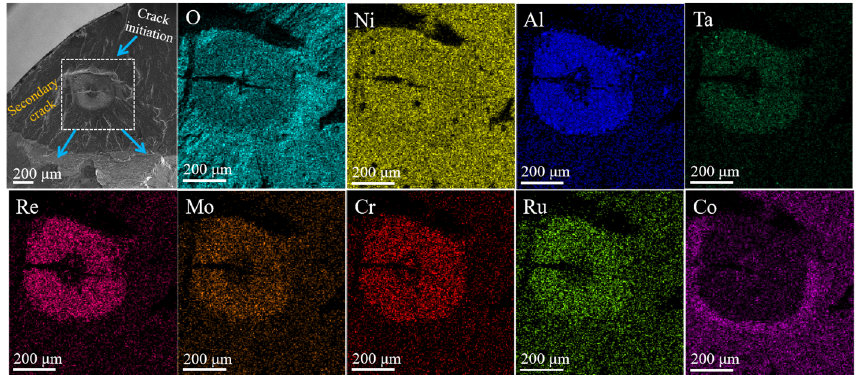
Figure 4. Scanning electron microscope (SEM) energy-dispersive X-ray spectroscopy (EDS),(SEM- EDS), maps of the micropores after fatigue at 980 °C under Δ ε t /2 = 0.8%.